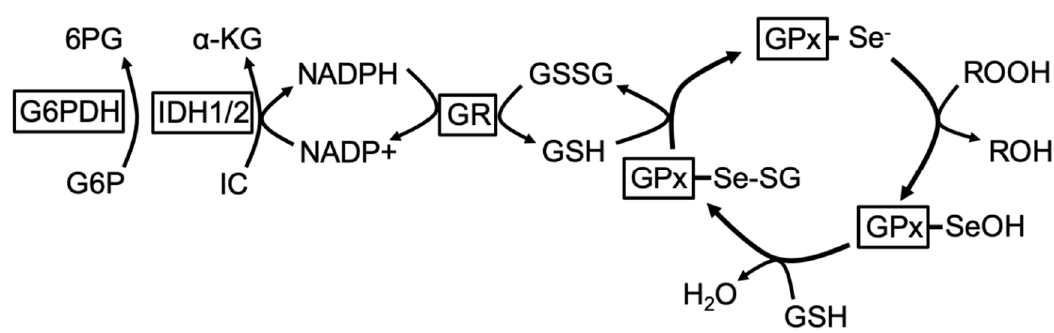
Figure 1. Schematic of the reduction of hydroperoxides by selenocysteine-containing glutathione peroxidases (GPx). The selenolate state (GPx-Se-) reduces hydroperoxides to water to form the oxidized selenenic acid (GPx-SeOH). GPx-SeOH reacts with GSH to generate selenenyl sulfide (GPx-SeSG), which is regenerated to the active selenol following nucleophilic attack of a second GSH and formation of oxidized glutathione (GSSG). GSSG is reduced back to GSH by glutathione reductase (GR). Nicotinamide adenine dinucleotide phosphate (NADPH) reducing equivalents for this reaction are mainly derived from isocitrate dehydrogenases (IDH)1 / 2, including the forward reaction of IDH2 in the tricarboxylic acid (TCA) cycle, and via the reduction of glucose-6-phosphate (G6P) in the pentose phosphate pathway by glucose-6-phosphate dehydrogenase (G6PDH). (Enzymes are indicated by boxes; α -KG: α -ketoglutarate; IC: isocitrate; 6PG: 6-phospho-gluconate.)